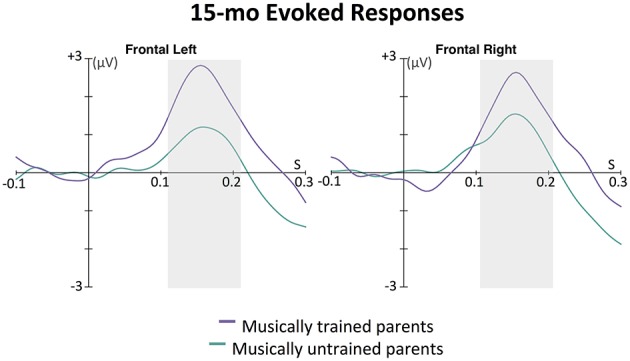
Grand average evoked responses (filters: 0.5 Hz highpass, 20 Hz lowpass) by 15-month-old infants to the first tone following a silence in the 12-beat sequence, shown in the left and right frontal grouping locations. The magnitude of the response for each group for each hemisphere was calculated as the area under the curve in a window ±50 ms around 160 ms for the left and 155 ms for the right hemisphere (shown with the gray boxes); these were the time points of the largest amplitude peak in grand average of the slow positive evoked responses. In an ANOVA with parent music training (high, low) as a between-subjects factor and hemisphere (left, right) as a within-subjects factor, only a main effect of parent music training was found. Infants with musically trained parents showed larger positive evoked responses to the sounds than infants without musically trained parents, p = 0.025.